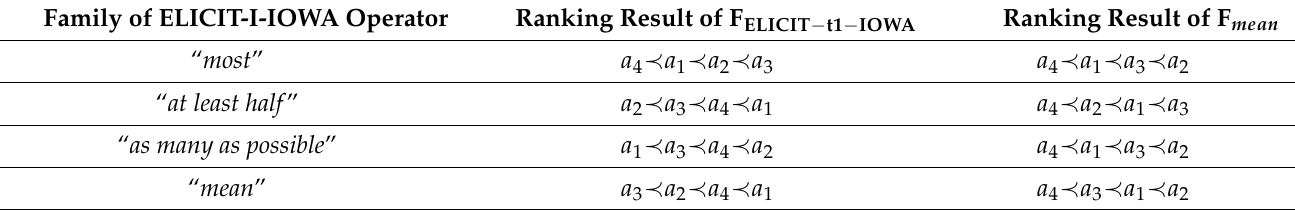
Table 5. The comparative result with ELICIT